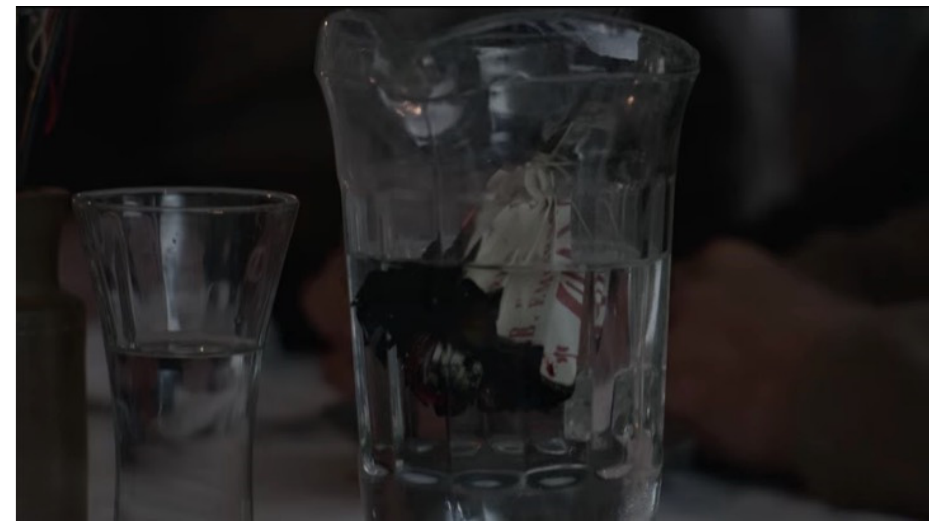
Figure 10. The Power of the Dog . Netflix.